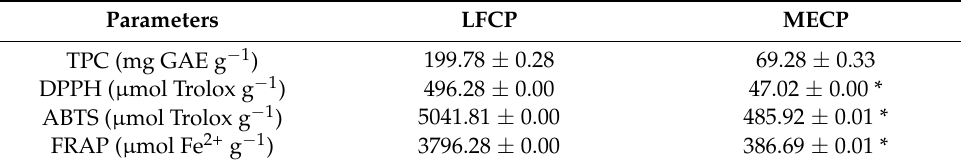
Table 1. Total phenolic compounds and antioxidant activity.